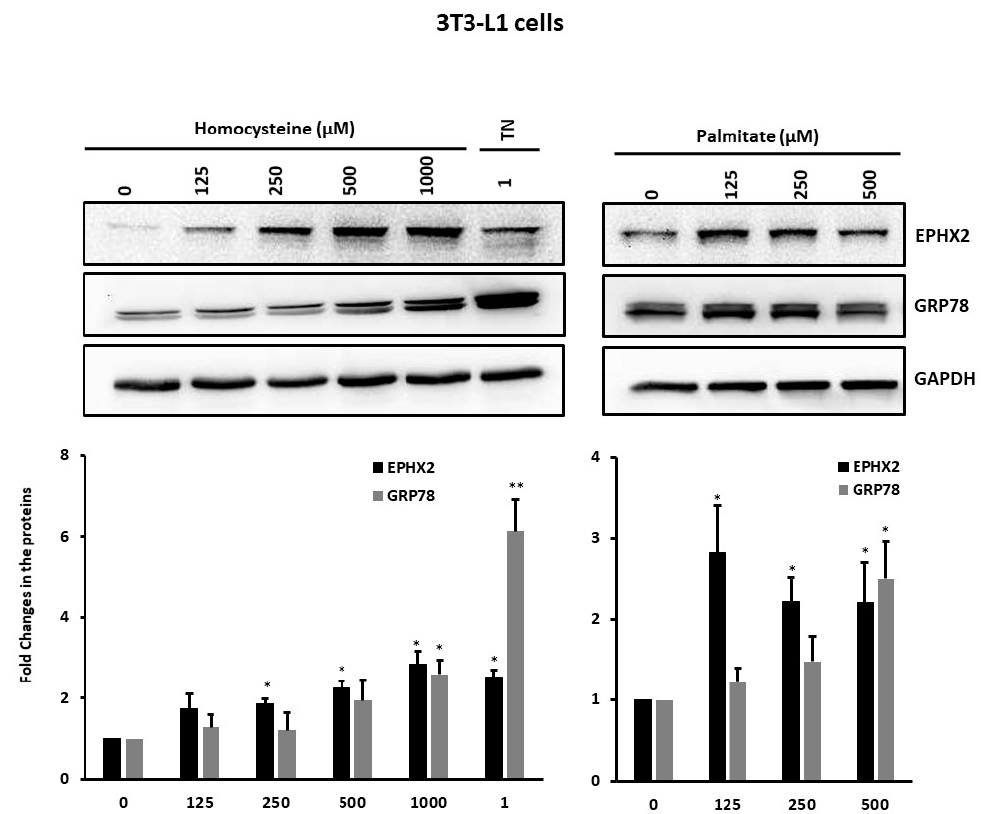
Figure 4. Expression levels of EPHX2 in 3T3-L1 preadipocytes under cellular stressor treatment. The protein levels were measured by Western Blot using 3T3-L1 preadipocytes treated overnight with various concentrations of homocysteine or palmitate or 1 µM Tunicamycin (at least three independent experiments). GRP78 was used as a control for treatment efficacy. * p < 0.05; ** p < 0.01.